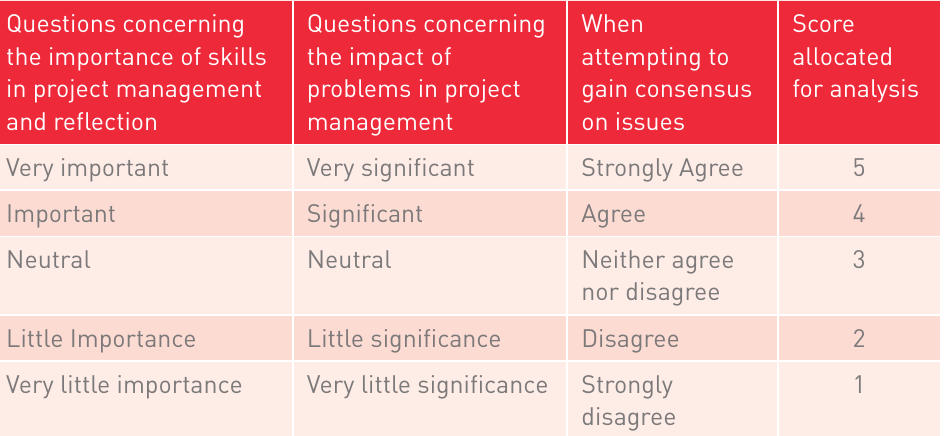
Likert scale options for the questions put to panel members and associated